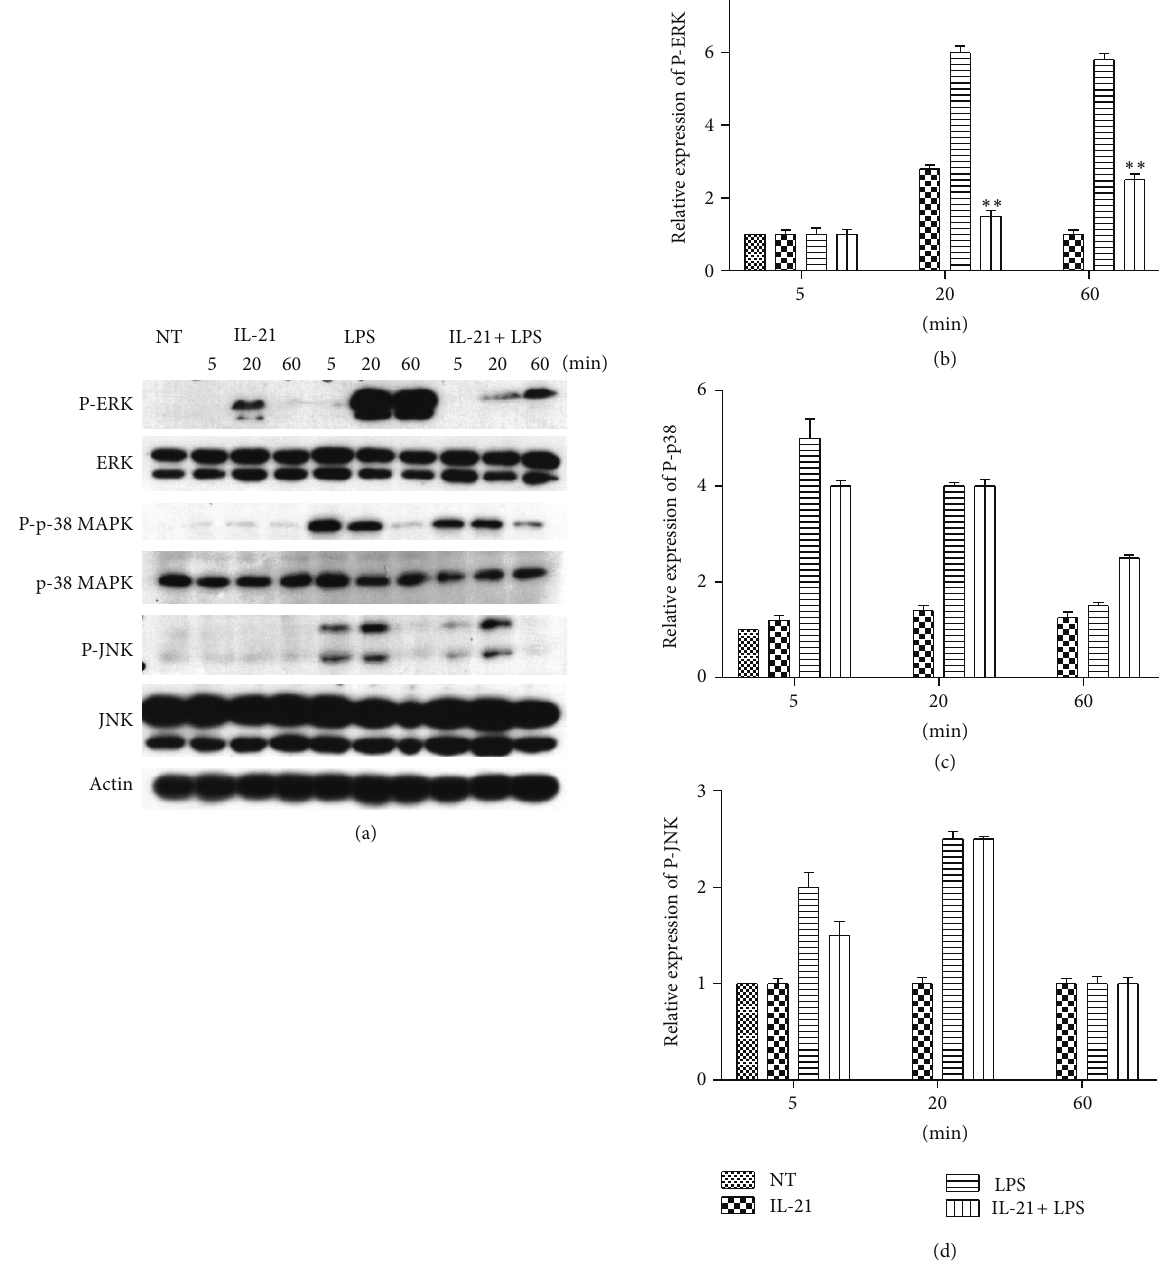
Figure 4: Effects of IL-21 on LPS-induced MAPKs signal pathway in mouse peritoneal macrophages. Macrophages ( 5 × 10 6 ) were incubated with IL-21 (100ng/mL) in the presence or absence of LPS (100ng/mL) for 5min, 20min, and 60min. Cytosolic proteins were analyzed by Western blotting for ERK1/2, p38 MAPK, and JNK phosphorylated. Detection of Actin was estimated as protein-loading control for each lane. Values are presented as mean ± SD of three independent experiments. ∗ 𝑃 < 0.05 , ∗∗ 𝑃 < 0.01 compared with the LPS